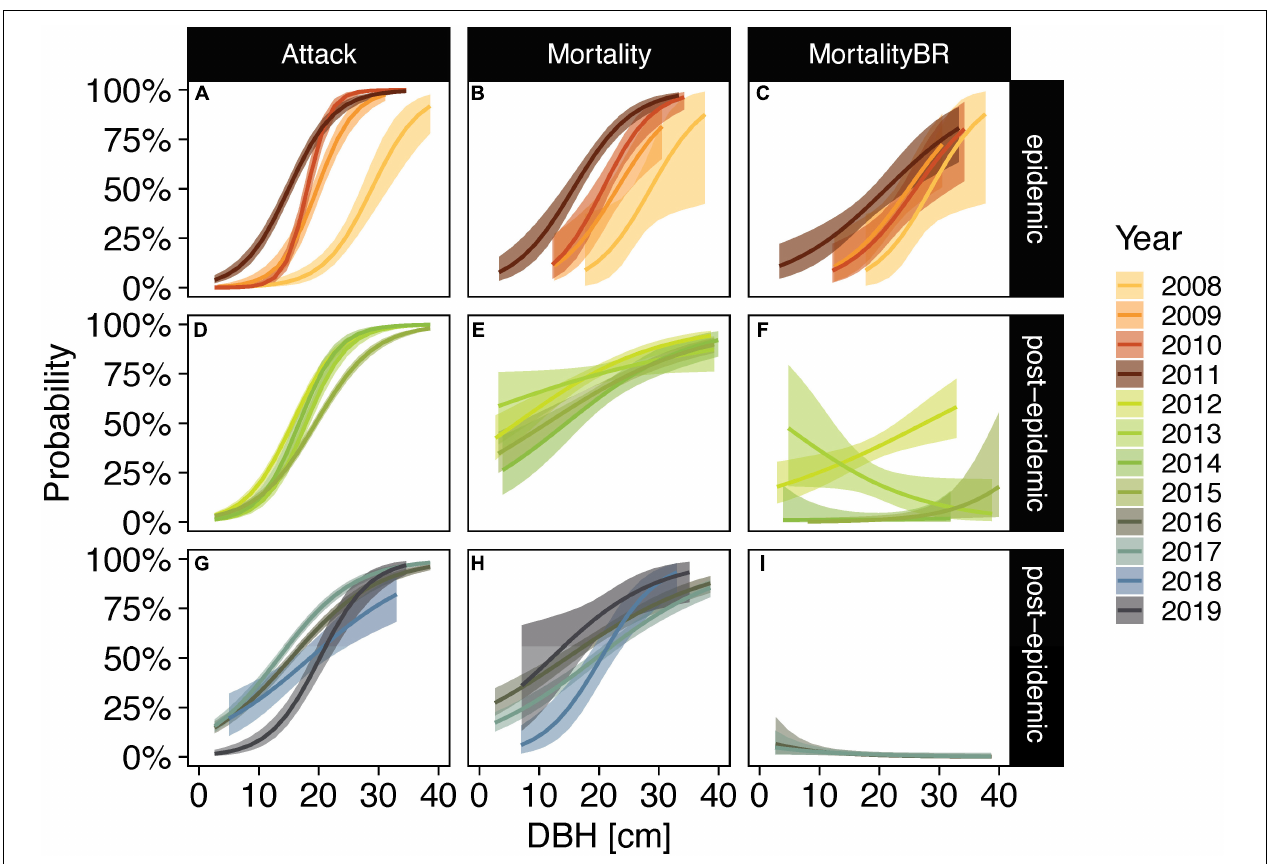
FIGURE 4 | Posterior probabilities of lodgepole pine trees exhibiting signs of bark beetle attack (A,D,G) , bark beetle caused mortality following attack (B,E,H) , and year-to-year mortality (C,F,I) in epidemic years [2008–2011; (A–C) ] and post-epidemic years [2012–2019; (D–I) ] as a function of diameter at breast height (DBH). Post-epidemic years were separated into individual panels showing four years each (2012–2015 and 2016–2019) for easier interpretation of data. Lines represent posterior medians and bands represent the 94% credible intervals.